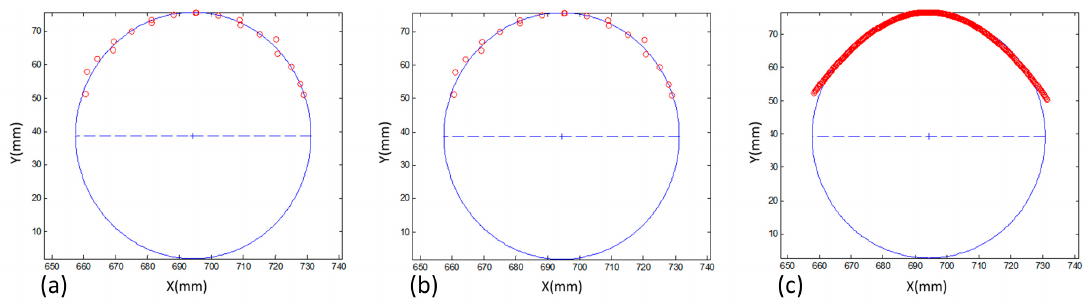
Figure 9. Circle fitting in the planimetric coordinates estimated with three different techniques: ( a ) photogrammetric intersection; ( b ) BBA and ( c ) ALSM + intersection.